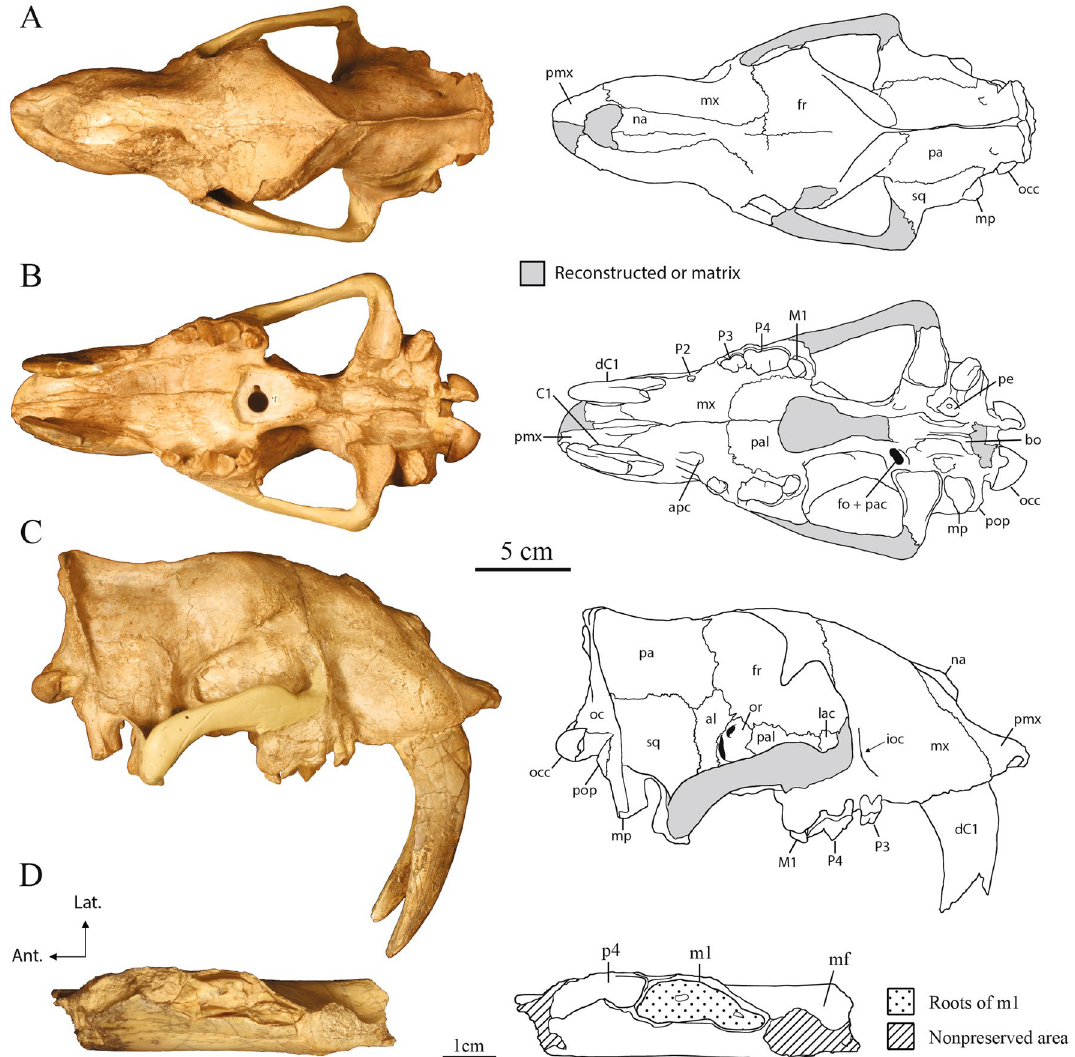
Figure 2. Cranium and dentary of USNM 12820, Eusmilus adelos , sp. nov. in dorsal ( A ), ventral ( B ), right lateral ( C ) and occlusal ( D ) views. Abbreviations: al alisphenoid, apc palatine canal anterior opening, bo basioccipital, fo foramen ovale, fr frontal, ioc infraorbital canal, lac lacrimal, mf masseteric fossa, mp mastoid process, mx maxilla, na nasal, oc occipital, occ occipital condyle, or orbitosphenoid, pa parietal, pac alisphenoid canal posterior opening, pal palatine, pe petrosal, pmx premaxilla, pop paroccipital process, sq canal opens through the maxilla, anterior of the P3, while the posterior margin of the tooth row extends beyond the posterior margin of the medial palate. The foramen ovale is located at the anterior margin of the glenoid fossa, and is joined in a common depression with the posterior entrance of the alisphenoid canal. The basicranial region is heavily buttressed with ventral projecting basioccipital flanges, suggesting a large attachment area for non-preserved bullar elements. The roof and medial wall of the petrobasilar canal for the inferior petrosal venous sinus is formed entirely by the basioccipital, whereas the petrosal contacts the basioccipital and contributes to the lateral wall of the canal along its preserved portion. The paroccipital process is simple and short, exhibiting a sutural contact with the mastoid process that travels into the auditory region. The petrobasilar foramen is aligned with this suture on the medial side of the auditory capsule, and is confluent with the petrobasilar canal. A large hypoglossal foramen is located posterior to the petrobasilar foramen, though separated by the basioccipital, within a groove between the occipital condyle and paroccipital process. In lateral view (Figs. 1, 2C; Supplementary Fig. S1c,d,g,h), the premaxillary dental arcade exhibits a significant amount of prognathism, with I1 and I2 extending more anteriorly than the I3. The infraorbital foramen is large and placed close to the antero-ventral corner of the orbit, above the center of the P3. The occiput is anteriorly rotated, creating an angle between the lambdoid crest and the cingular border of the cheektooth row of approxi- mately 90°, compared to a mean value of 116 for Hoplophoneus primaevus 6 . Portions of the left and right dentaries (Fig. 2D) are preserved in USNM 12820, but no teeth are present in either dentary. However, judging from the alveoli, the p4 would have been large (length 19.39 mm; width 6.51 mm, measurements for right side). Given the orientation of the roots, this tooth in life would have presented